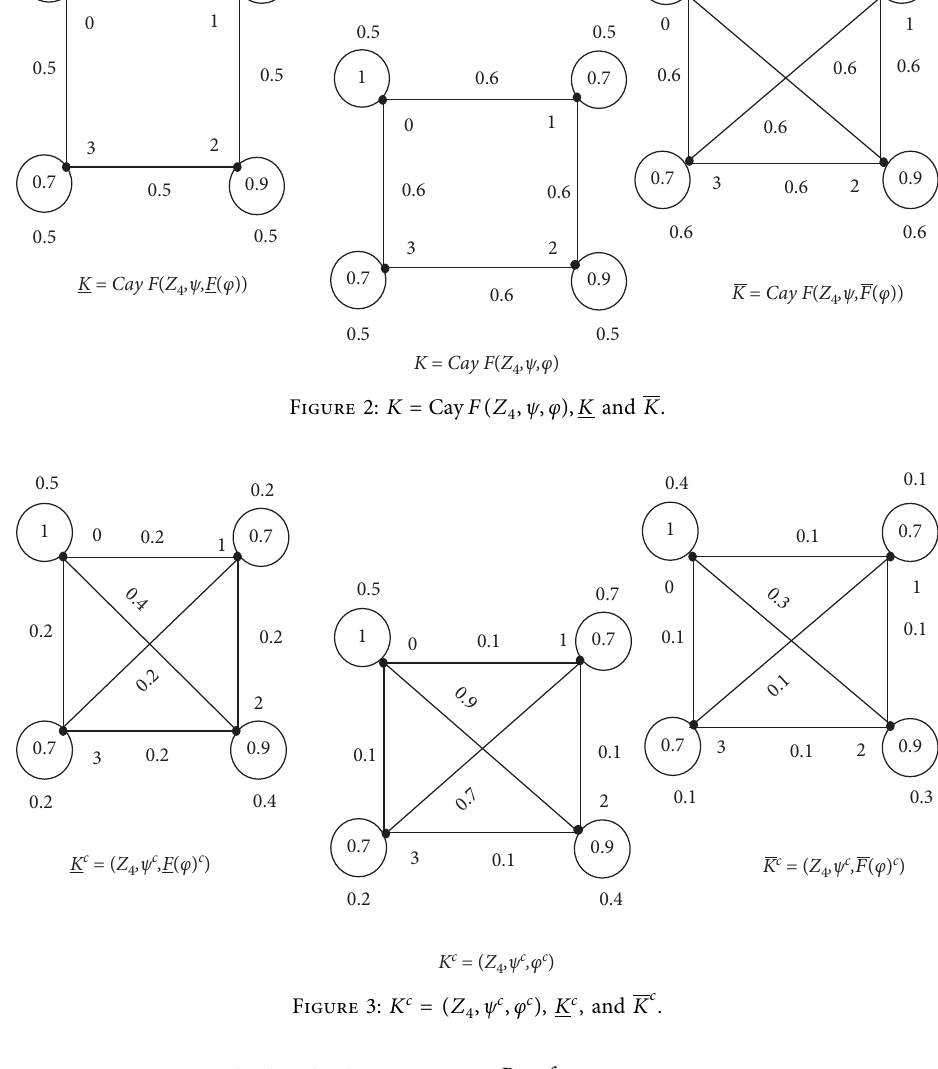
, ψ c , φ c ) , K c , and K c . 4